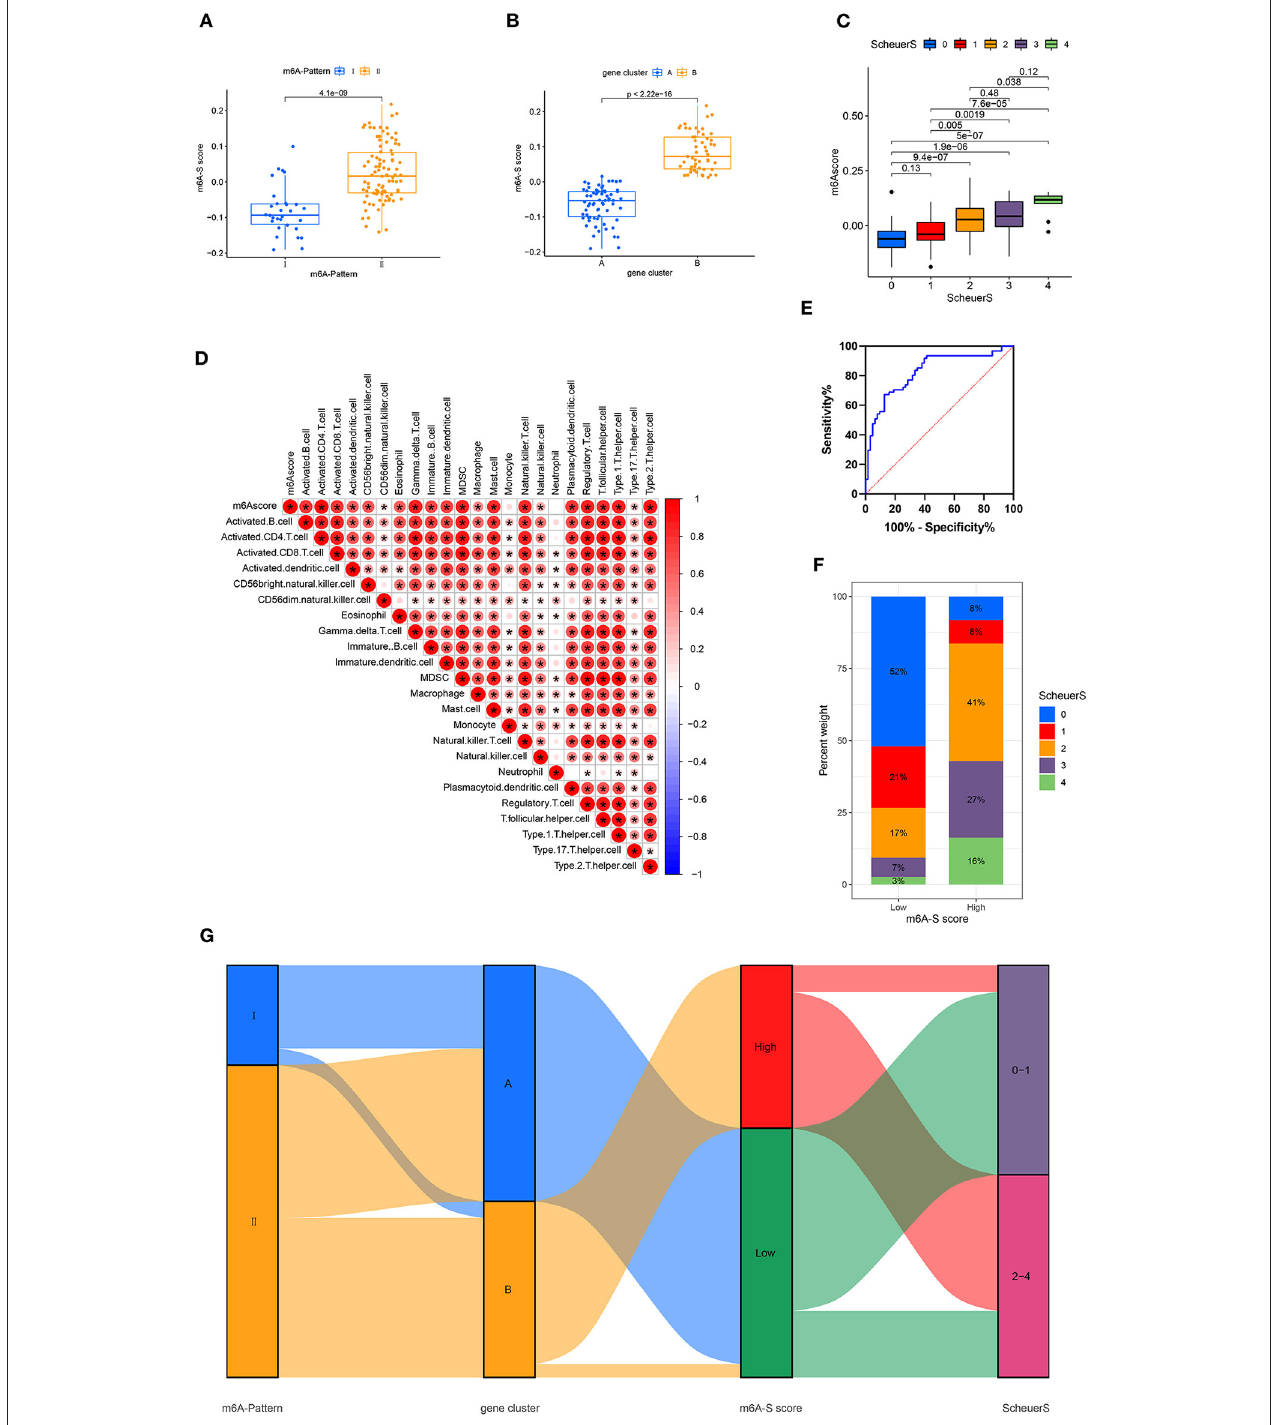
FIGURE 3 | Construction of m6A-S score. (A) Difference of m6A-S score between two m6A modification patterns. (B) Difference of m6A-S score between two gene clusters. (C) Comparison of m6A-S scores among patients in different liver fibrosis stages. (D) Correlations between m6A-S score and infiltrating immune cells. (E) The receiving-operating characteristic (ROC) curve analysis of the m6A-S score were used to differentiate the mild and severe stage of liver fibrosis. The area under the curve was 0.820 with p < 0.001 and the 95% CI was 0.754–0.902. (F) The proportion of disease stages in high and low m6A-S score group. (G) Sankey diagram showing the relationship among m6A patterns, gene clusters, m6A-S score groups, and fibrosis severity.